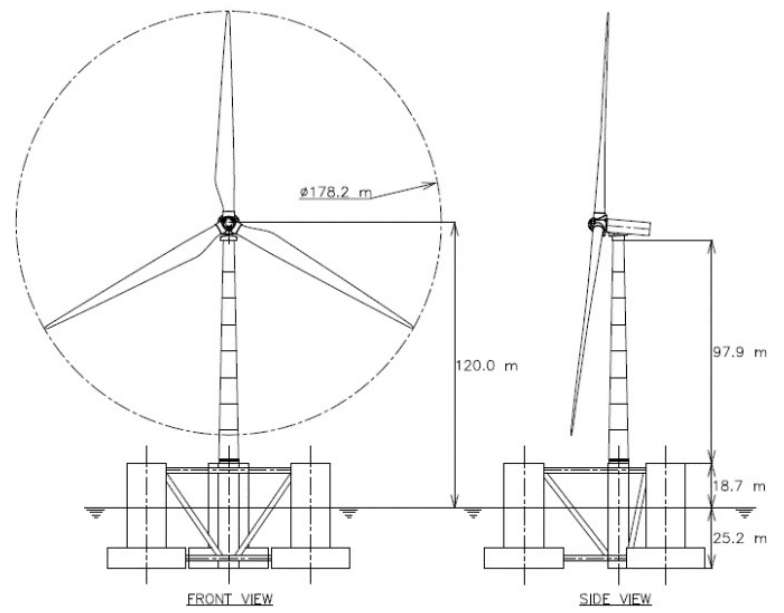
Figure 2. Full-scale layout of the UOU 10 MW FOWT.